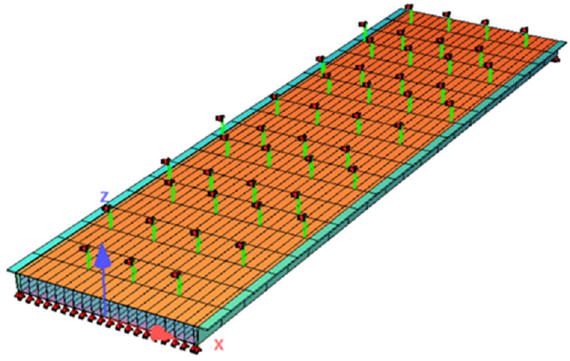
Figure 3. Numerical model of web-core sandwich panel FRP bridge in Puurs with SDOF pedestrians.